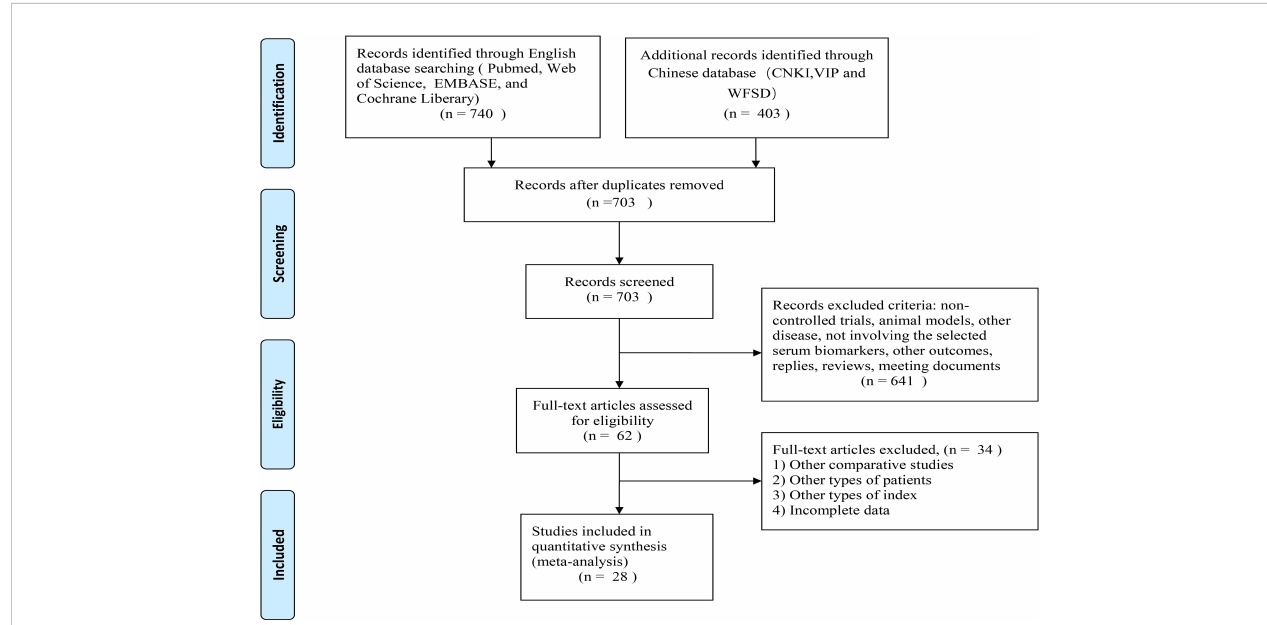
FIGURE 1 Literature search strategy and screening